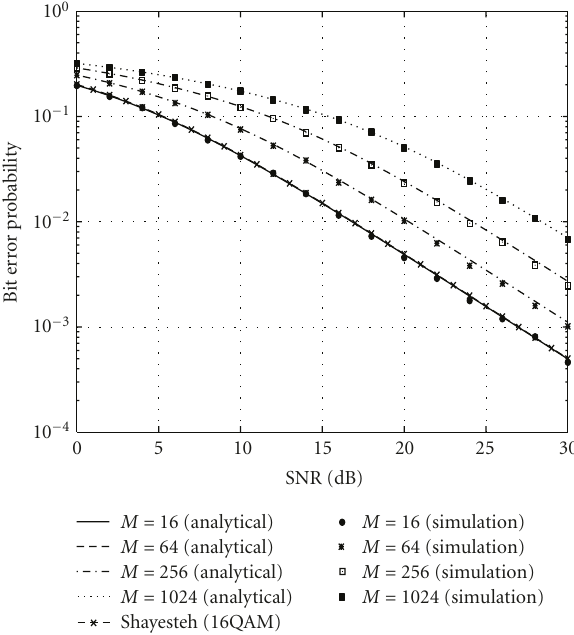
Figure 4: BEP for M -QAM subject to Nakagami- m fading for m = 1 and di ff erent values of M